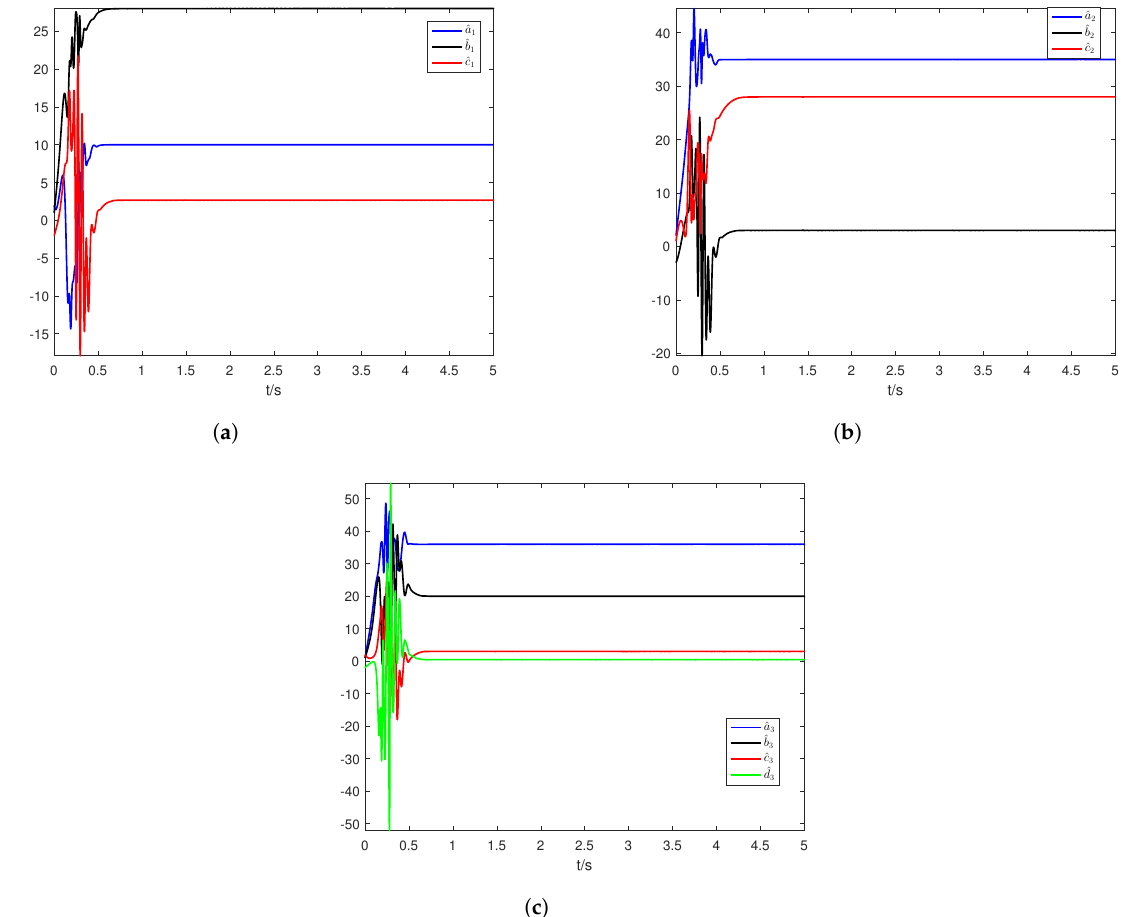
Figure 17. The estimation of parameters ˆ a 1 , ˆ b 1 , ˆ c 1 of drive system (43) ( a ), ˆ a 2 , ˆ b 2 , ˆ c 2 of drive system (44) ( b ), ˆ a 3 , ˆ b 3 , ˆ c 3 , ˆ d 3 of drive system (46) ( c ).